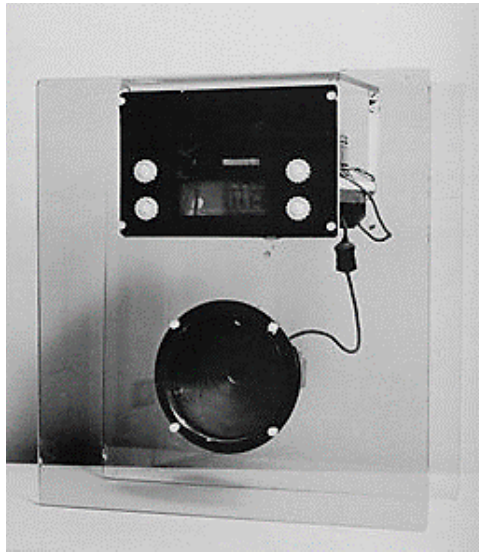
Figure 9. Franco Albini. The radio cabinet (1938–1940). The final project was presented for the Wohnbedarf competition in Zurich (1940). Image from Domus (1941).